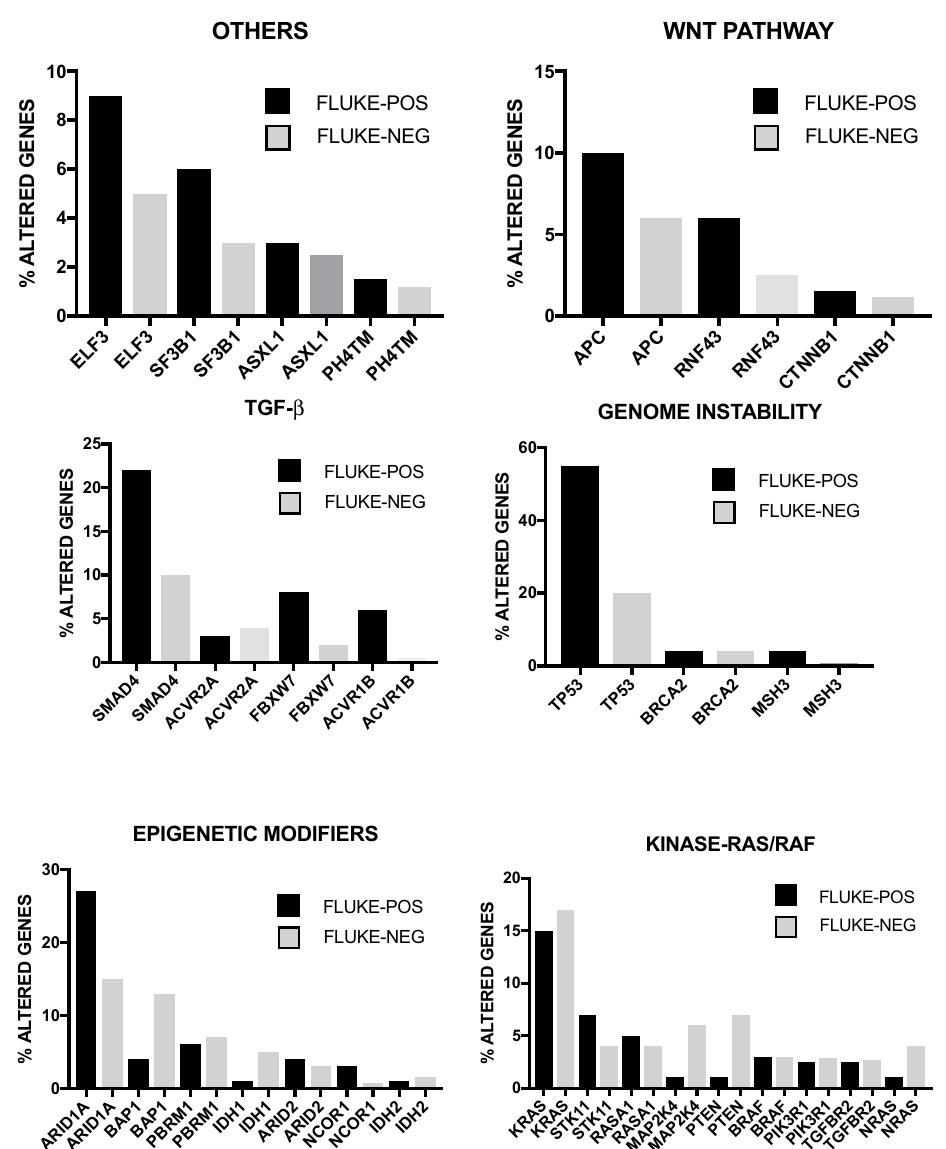
Figure 3. Frequently mutated genes in CCAs, subdivided into fluke-positive and fluke-negative patients. The data were based on the analysis of 489 CCAs and were reprinted from Jusakul et al. [34].